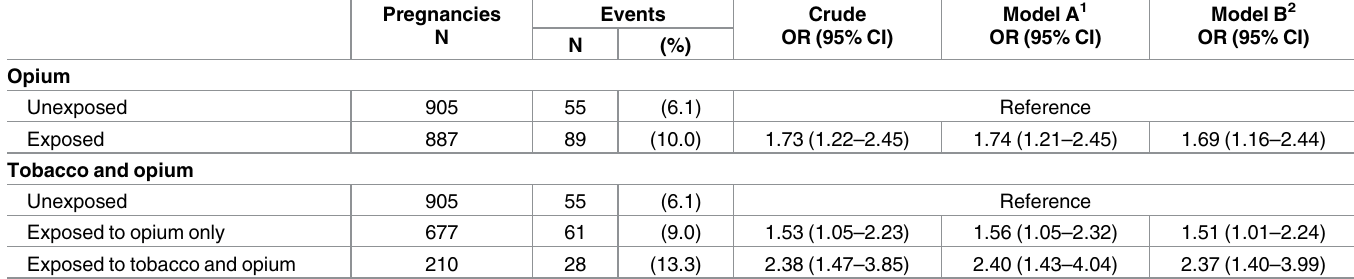
Table 2. Odds ratios (OR) and 95% confidence intervals(CI) for association between opium and tobacco use during pregnancy and risk of preterm delivery.